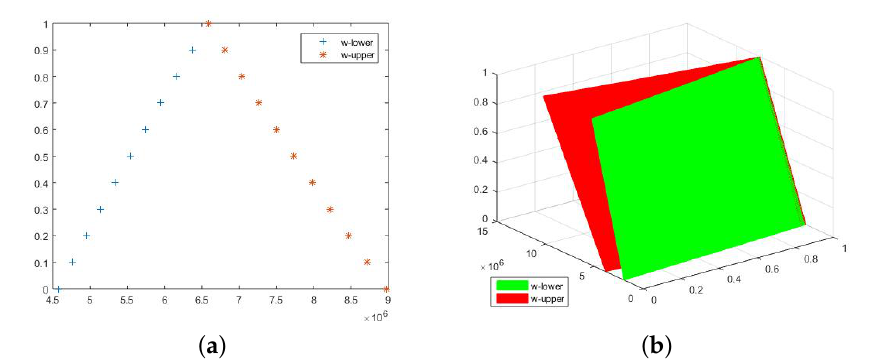
Figure 5. The exact lower and upper solutions of Equation (151) at Λ = 0.6, ϕ = 0.8, t = 5, (cid:61) = 1, ı = 2. ( a ) 2 D figure for the exact solutions of two-dimensional fuzzy fractional diffusion equation of w in Example 9. ( b ) 3 D figure for the exact solutions of w in Example 9.